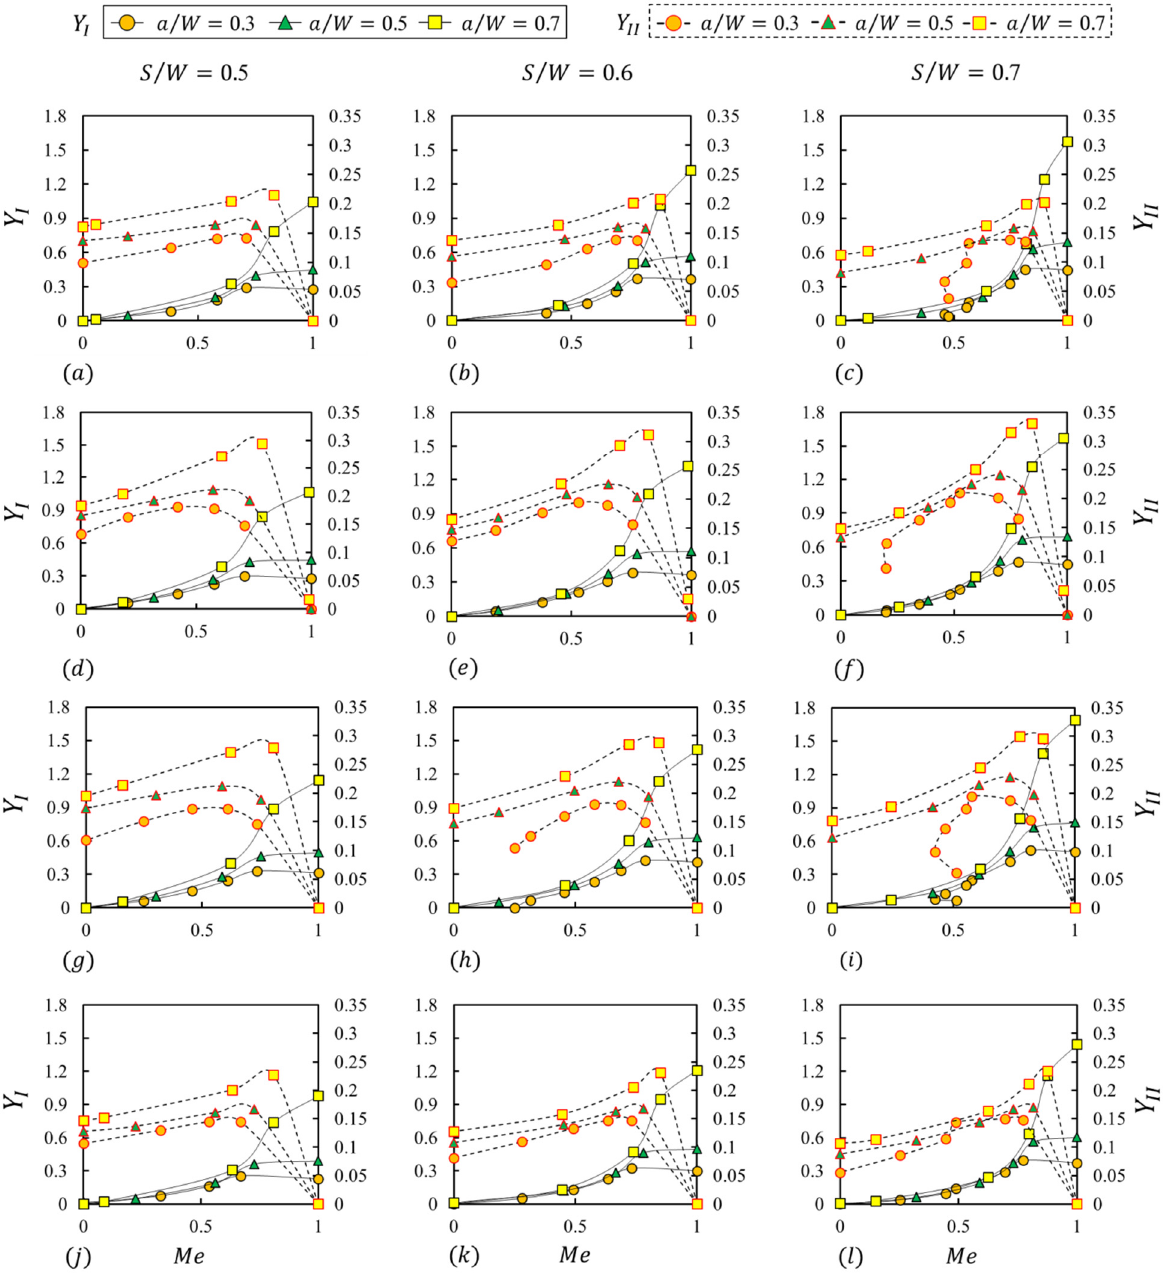
Figure 6. Variations of geometry factors with mode mixity parameter in the BISBB specimen and for different geometry and loading conditions. ( a – c ) Al-Adhesive-Alumina, ( d – f ) Alumina-Adhesive-Al, ( g – i ) Al-Adhesive-Al, ( j – l ) Alumina-